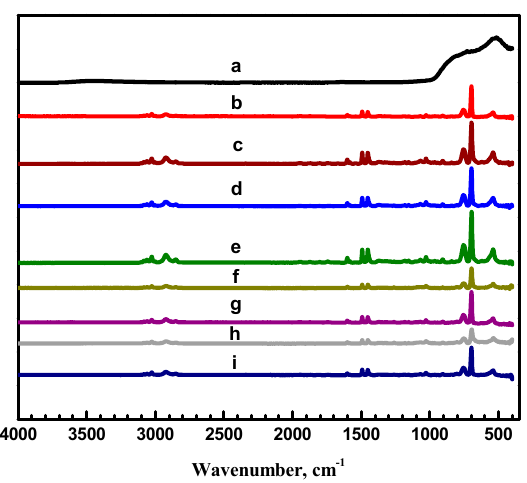
Figure 5. FTIR for ( a ) Al 2 O 3 nanoparticles, ( b ) PS1, ( c ) PS2, ( d ) PS3, ( e ) PS4, ( f ) PA1, ( g ) PA2, ( h ) PA3, and ( i ) PA4.